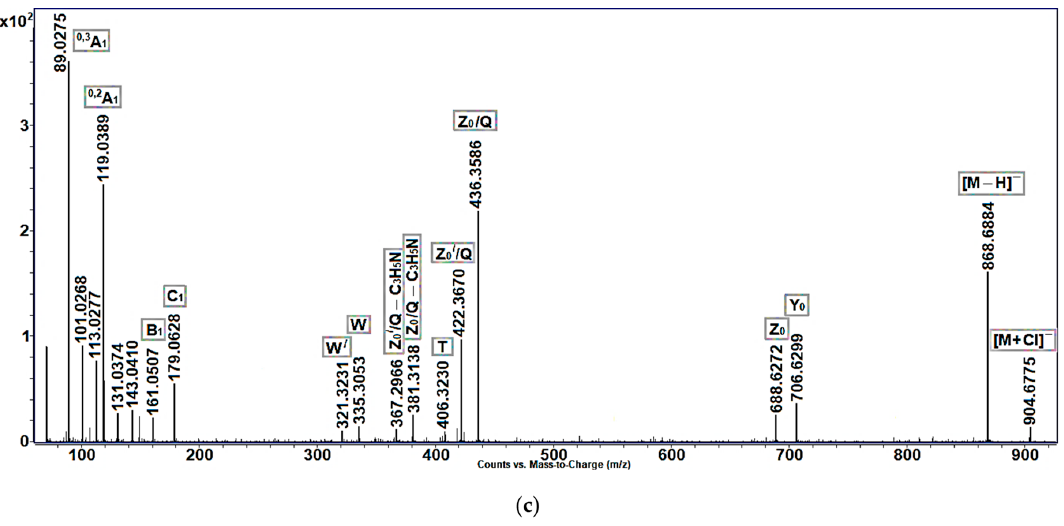
Figure 4. ( − )ESI-MS/MS spectra of [M + Cl] ‒ and [M − H] ‒ ions of isomeric ( a ) allylic hydroperoxides 1a , 1b , 2a , 2b , 3c , 3d , ( b ) allylic alcohols 1a / , 1b / , 2a / , 2b / , 3c / , 3d / , and ( c ) enones 1a // , 1b // , 2a // , 2b // , 3c // , 3d // .